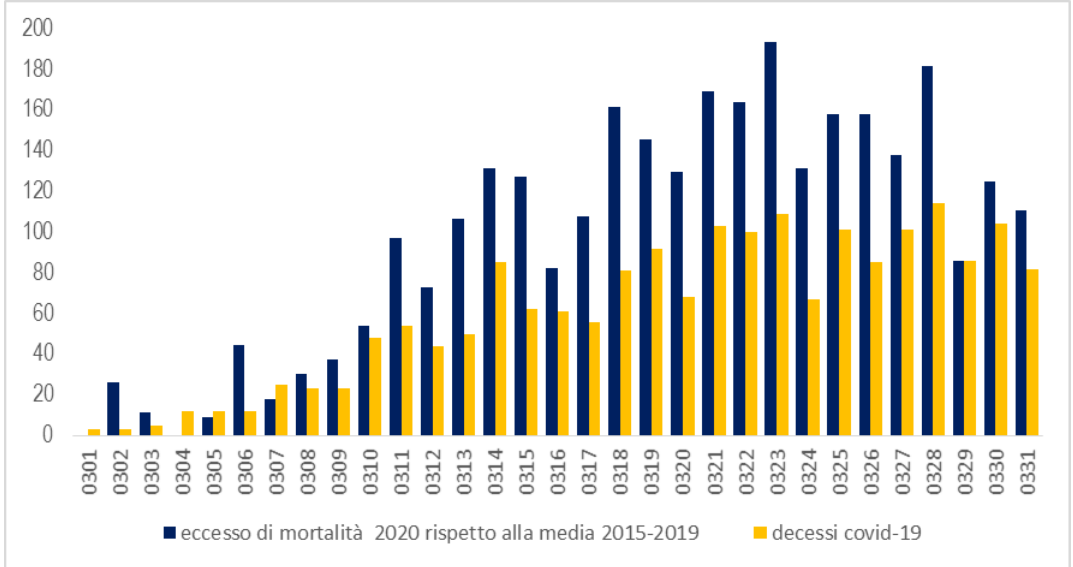
Figura 9. Andamento giornaliero nel mese di marzo dell'eccesso di mortalità totale registrato nel 2020 rispetto alla media degli anni 2015-2019 e dei decessi Covid-19 (a) e loro rapporto %. Valori assoluti dei decessi di persone in età 50 anni e più. Regione